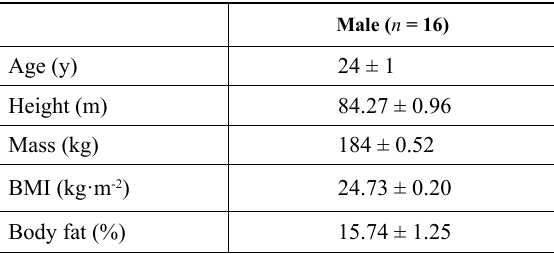
Table 1. Physical characteristics of the